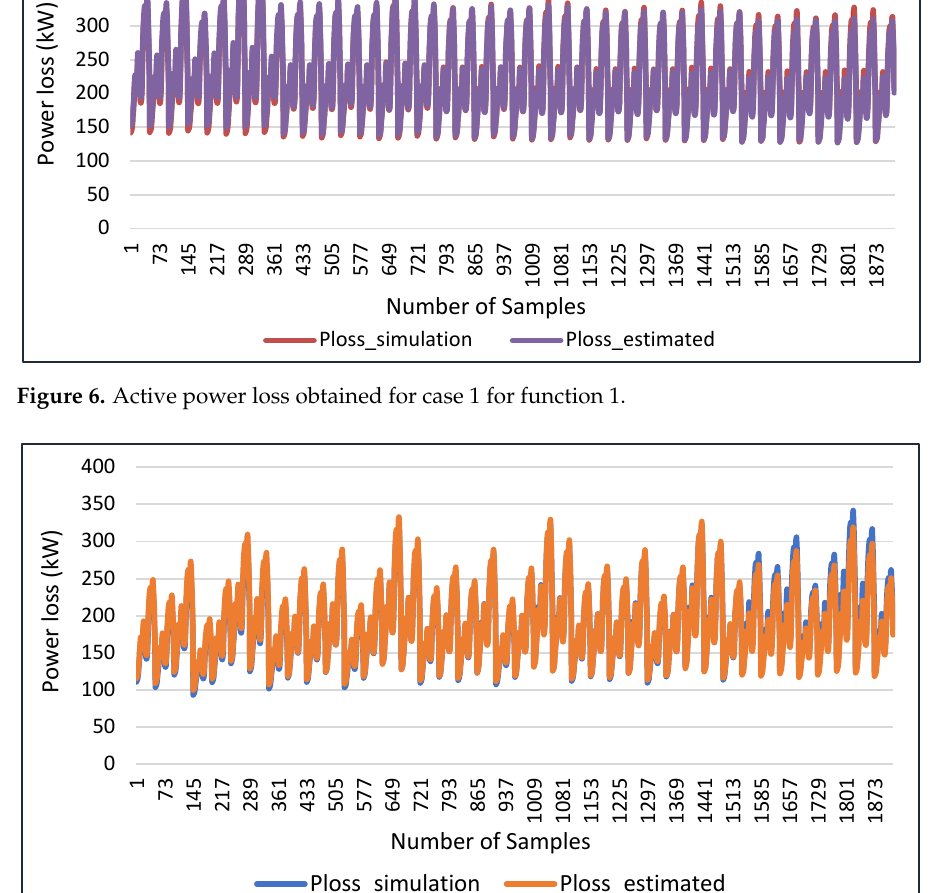
Figure 7. Active power loss obtained for case 2 for function 1.